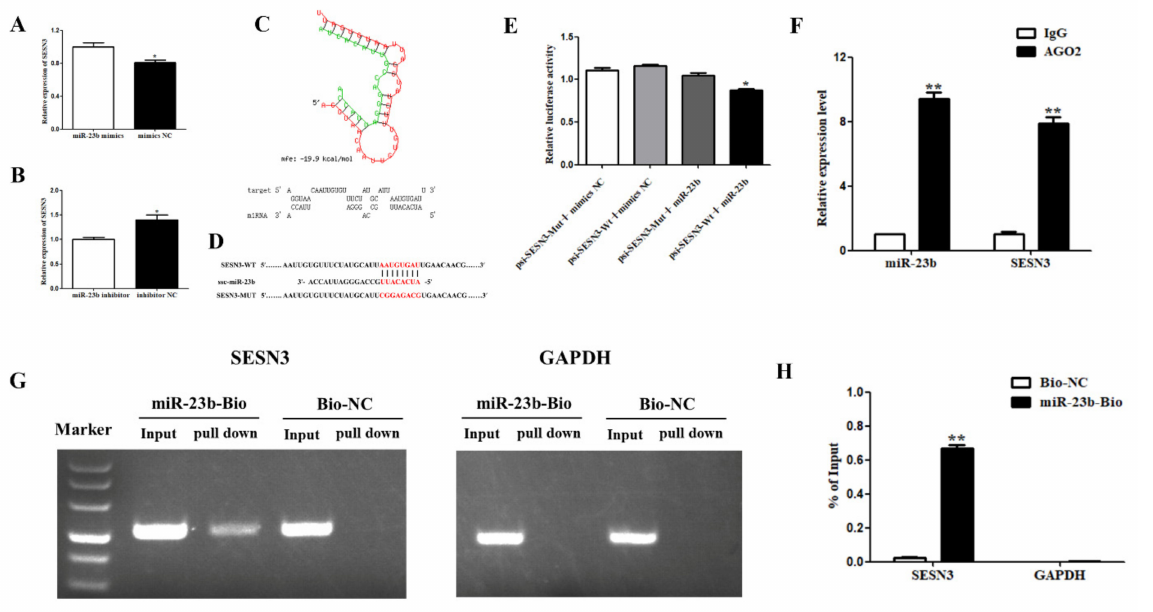
Figure 4. SESN3 serve as a miR-23b sponge. ( A , B ) Expression changes of SESN3 following trans- fection with miR-23b mimics or inhibitor; ( C ) the predicted results of binding sites of SESN3 and miR-23b; ( D ) the sequence of psiCHECK2-circIGF1R-Wt and psiCHECK2-circIGF1R-Mut; ( E ) the results of dual-luciferase reporter assay; ( F ) the results of AGO2-RIP assay; ( G , H ) the results of miR-23b pulldown. Note: * indicted significant difference at 0.05 level, and ** indicted significant difference at 0.01 level.